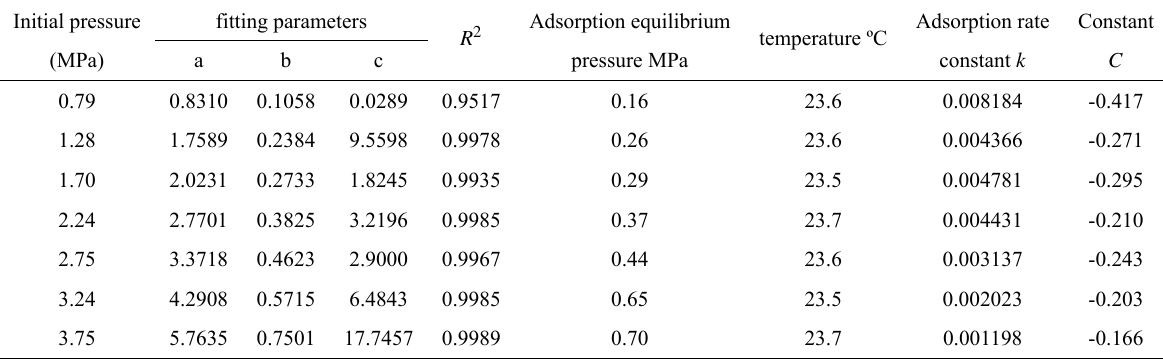
Adsorption rate constants for dry coal under different initial pressures ( R 2 is the correlation coefficient, the closer the coefficient is to 1, indicating that the stronger the correlation, the higher the degree of fit).